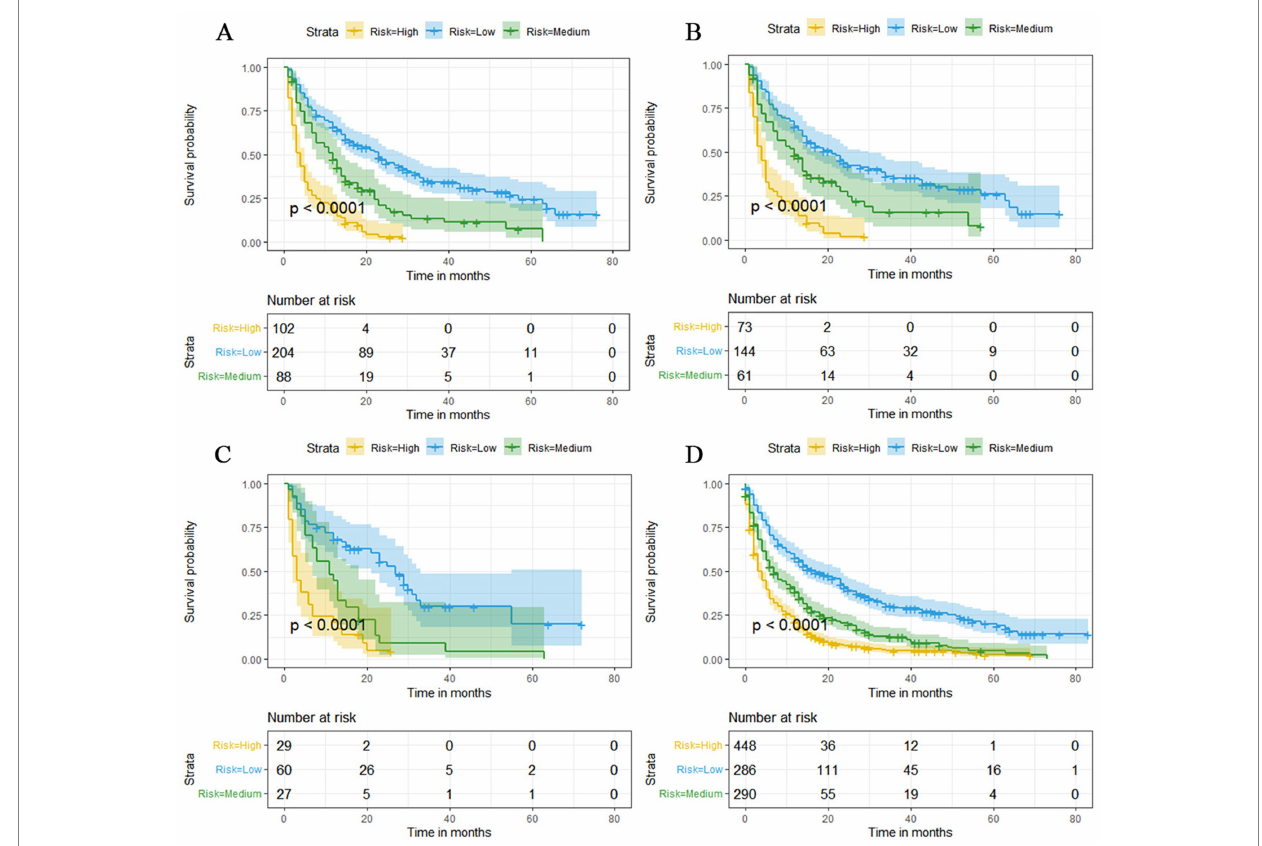
FIGURE 13 Kaplan–Meier survival curves for three high, medium and low mortality risk subgroups in the overall elderly kidney cancer with bone metastasis (KCBM) set (A) , training set (B) , validation set (C) and extended validation set (D)